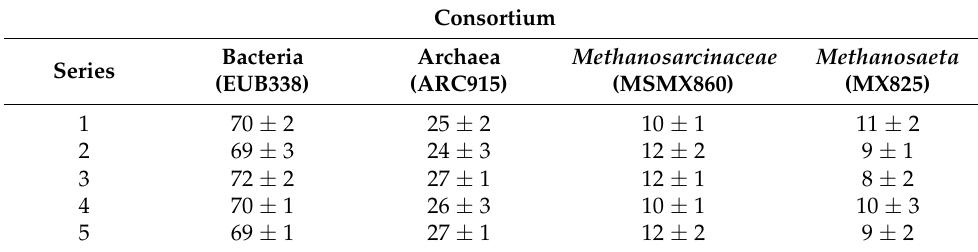
Table 5. Microbial taxonomy in AS in particular experimental